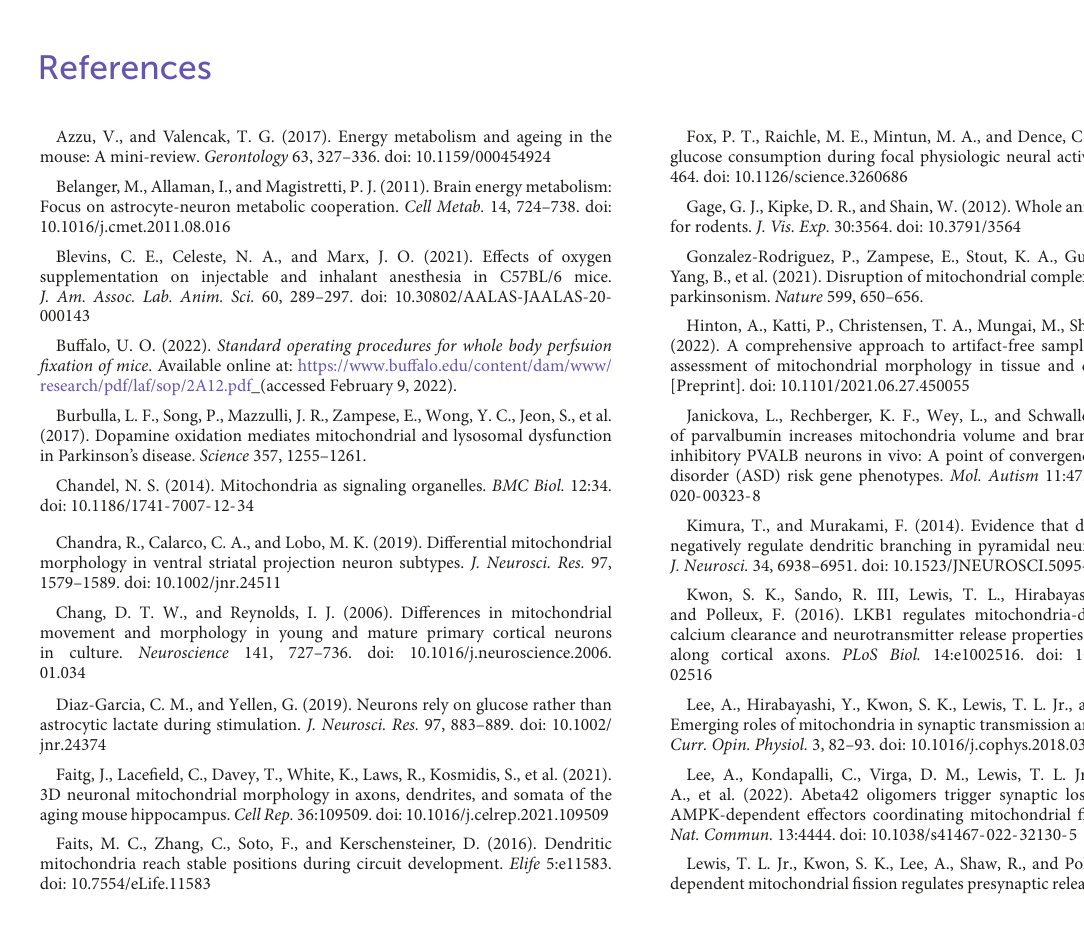
SUPPLEMENTARYFIGURE2 In utero electroporation strategy for sparse labeling of cortical neurons in vivo . A “DIO” plasmid encoding mitochondrial targeted mScarlet and cytoplasmic Venus was mixed with a low concentration of a second plasmid encoding Cre and then electroporated in E15.5 pups to give sparse labeling of cortical neurons in vivo .